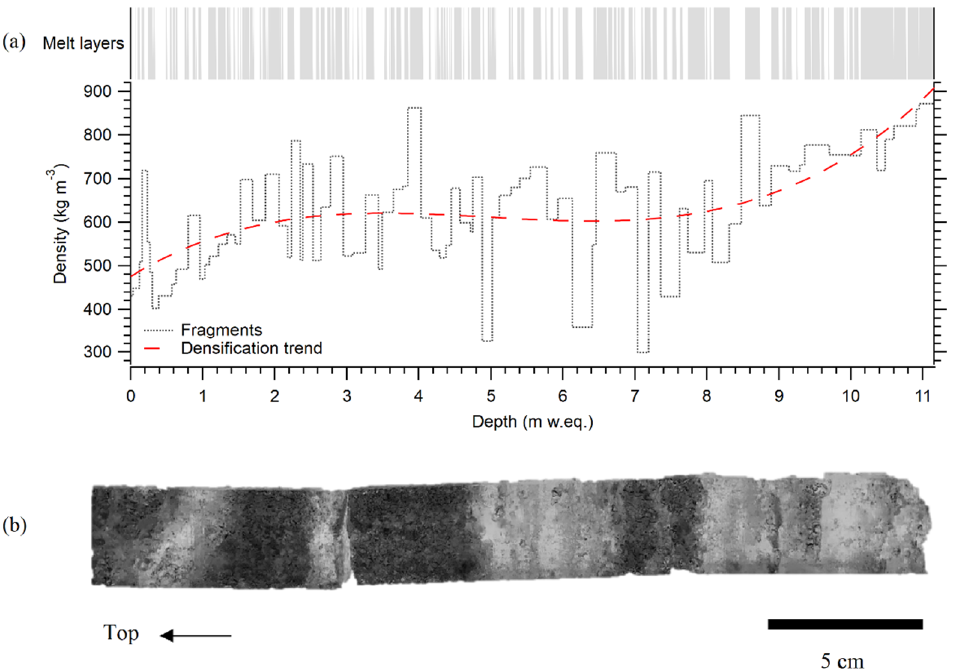
Figure 4. ( a ) Density profiles derived from ice core fragments on water equivalent depth scale (w.eq.) including the overall trend based on polynomial fit, plotted against the record of melt layers (grey vertical lines); ( b ) Alternation of non-melt (darker) and melt-affected sections (lighter) within the Young Island ice core at 1.47–1.63 m w.eq. depth (equals 2.85–3.15 m snow depth) acquired from digital black-and-white photography; figure redrawn from [35].